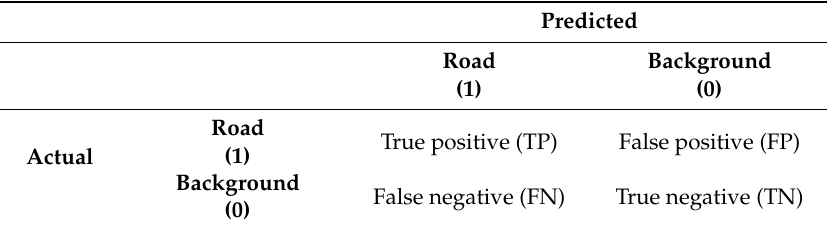
Table 1. Definitions of TP, TN, FP, and FN